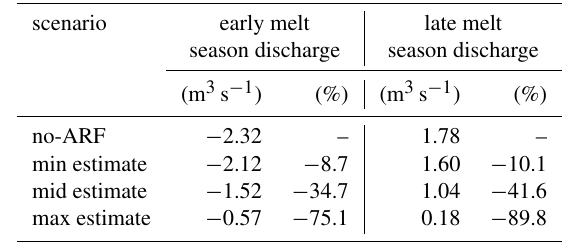
Table 4. Season mean volume error in discharge during the early (22 March to 29 May) and late (30 May to 10 August) melt sea- sons of the no-ARF, min, mid, and max scenarios compared to ob- served discharge. The percentage change shows an increase ( + ) or decrease ( − ) in the volume error compared to the no-ARF volume error.